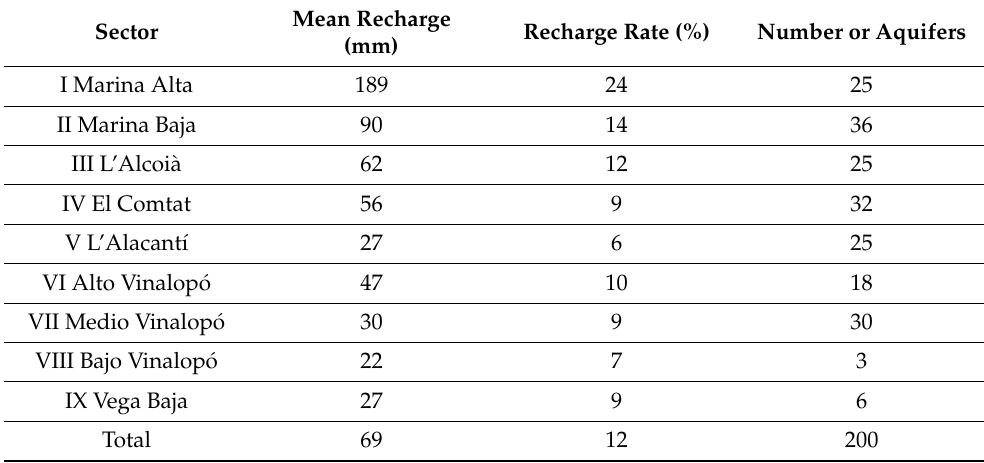
Table 1. Weighted averages of recharge from precipitation expressed as mean annual millimeters (mm) and recharge rates (in %) for different sectors in the province of Alicante. Mean Recharge Sector Recharge Rate (%) Number or Aquifers (mm) I Marina Alta 189 24 25 II Marina Baja 90 14 36 III L’Alcoi à 62 12 25 IV El Comtat 56 9 32 V L’Alacant í 27 6 25 VI Alto Vinalop ó 47 10 18 VII Medio Vinalop ó 30 9 30 VIII Bajo Vinalop ó 22 7 3 IX Vega Baja 27 9 6 Total 69 12